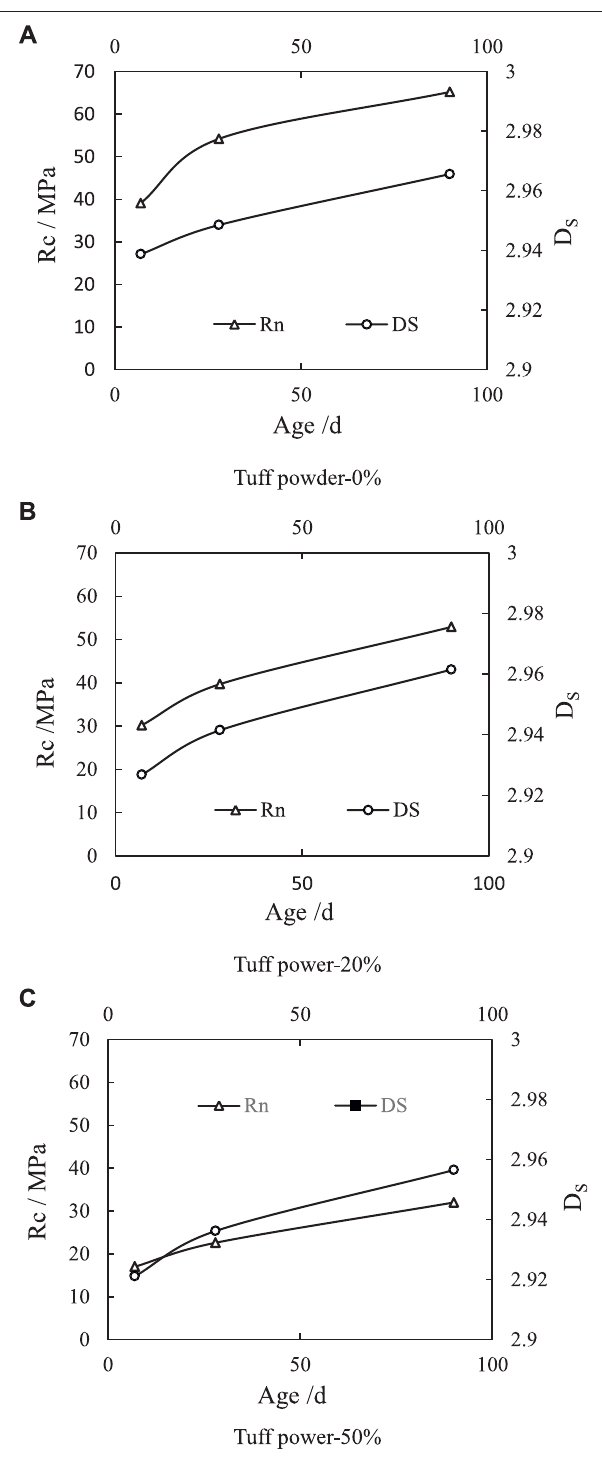
FIGURE 12 | The relationship between R c and D